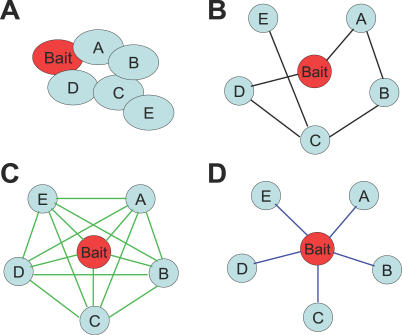
PPI Network Representations of Protein Complexes(A) A hypothetical protein complex. Binary protein−protein interactions are depicted by direct contacts between proteins. Although five proteins (A, B, C, D, and E) are identified through the use of a bait protein (red), only A and D directly bind to the bait.(B) The true PPI network topology of the protein complex.(C) The PPI network topology of the protein complex inferred by the “matrix” model, where all proteins in a complex are assumed to interact with each other.(D) The PPI network topology of the protein complex inferred by the “spoke” model, where all proteins in a complex are assumed to interact with the bait; no other interactions are allowed.